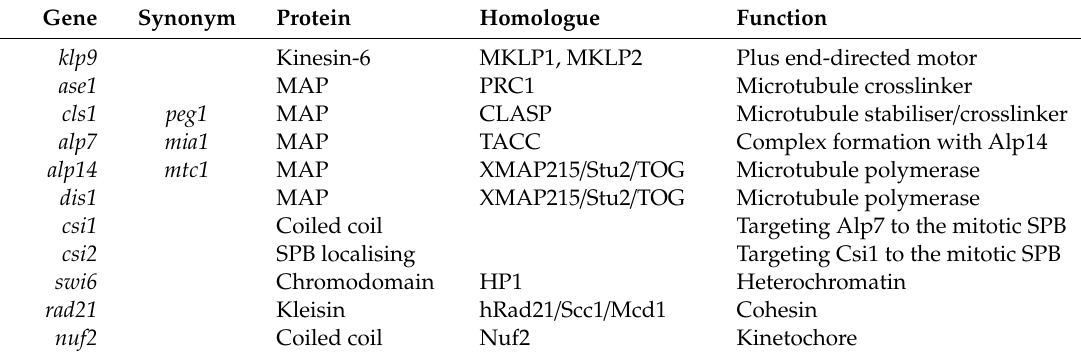
Table 2. List of spindle outward force generators in fission